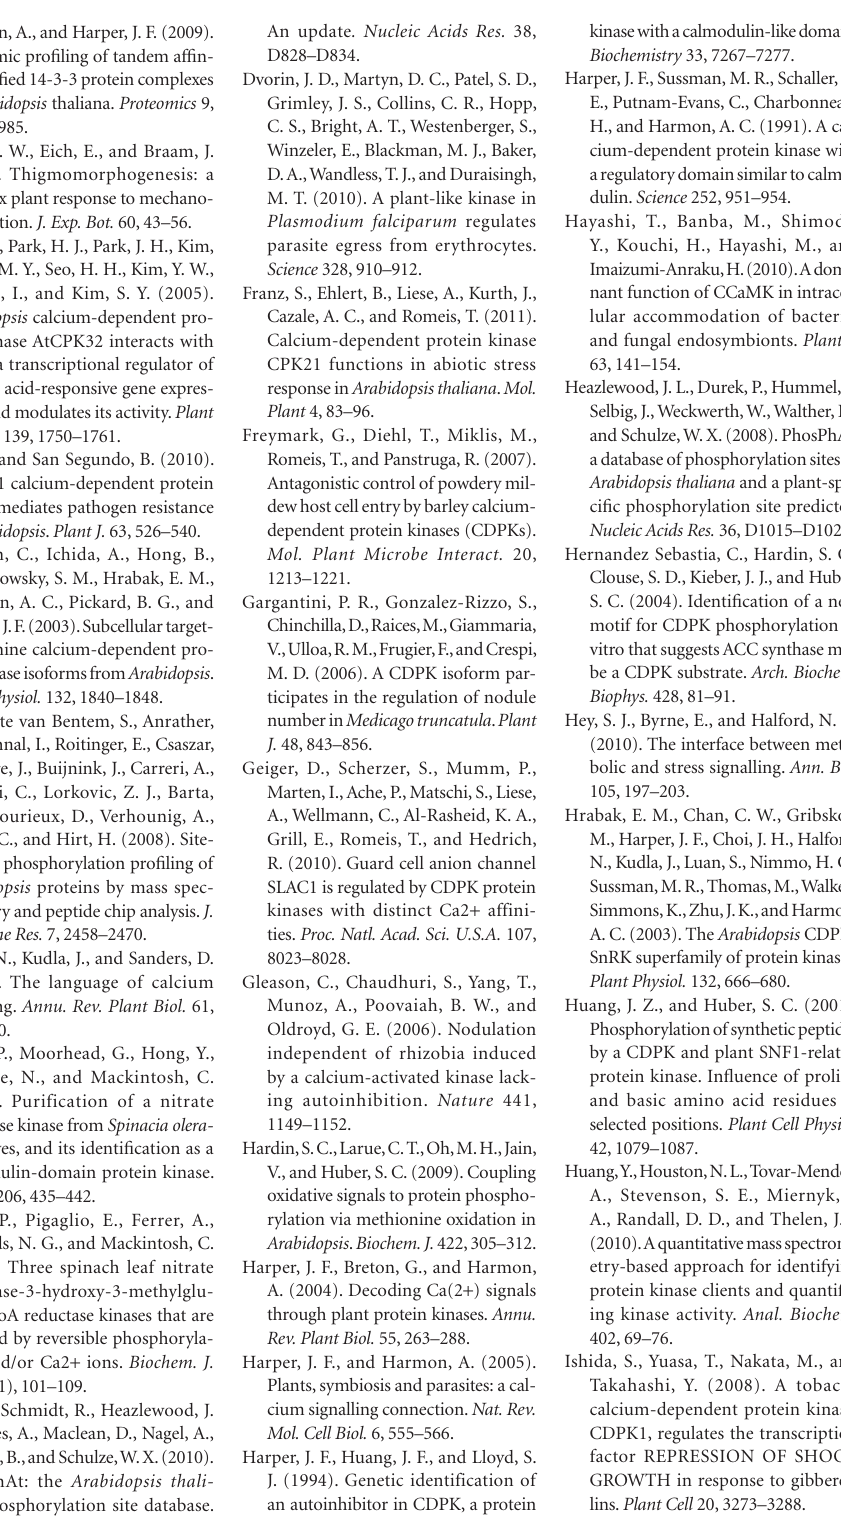
Table S1 | Peptides tested in SPA assays. Each peptide was made with norleucine substitutions for methionines (except ach-375), and a biotin tag on the N-terminal end. Table S2 | Sequences of plasmids used in this